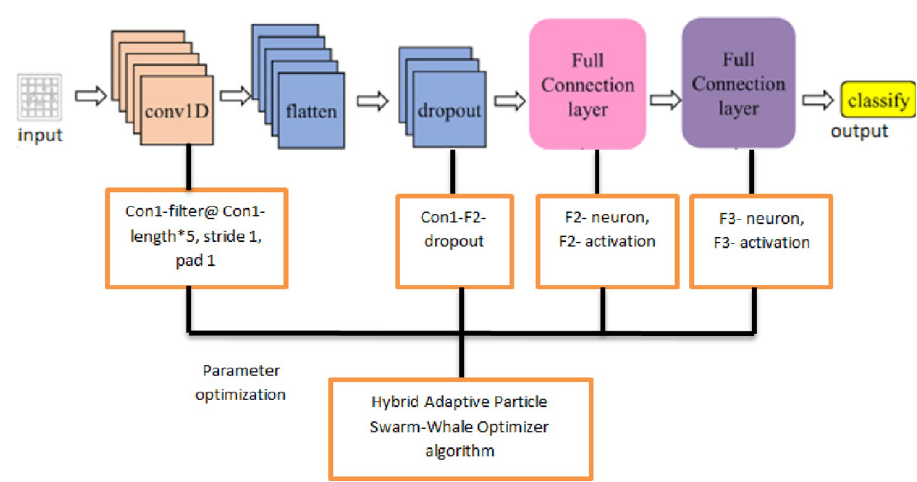
Fig 1. The detailed network structure model of CNN’s one-dimensional